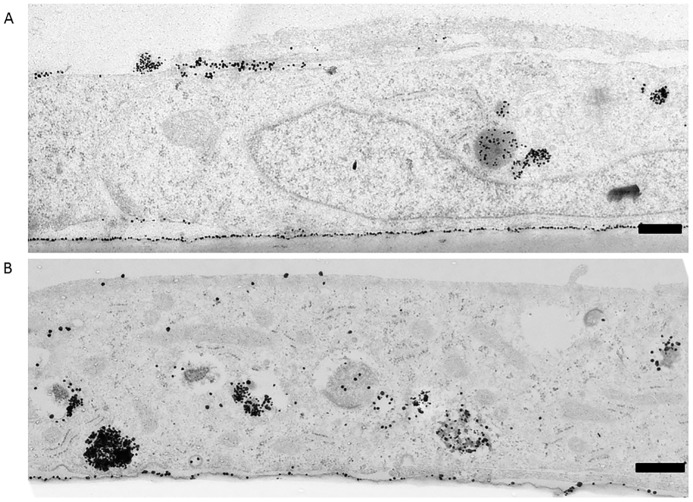
TEM of PEG-amine/galactose nanoparticles in endothelial cells.Silver-enhanced nanoparticles in endothelial cells, 3 hrs after their application to the apical (upper) cell surface. (A) Brain endothelial cells, hCMEC/D3. (B) Kidney endothelial cells, ciGENC. Scale bar = 0.5 μm.